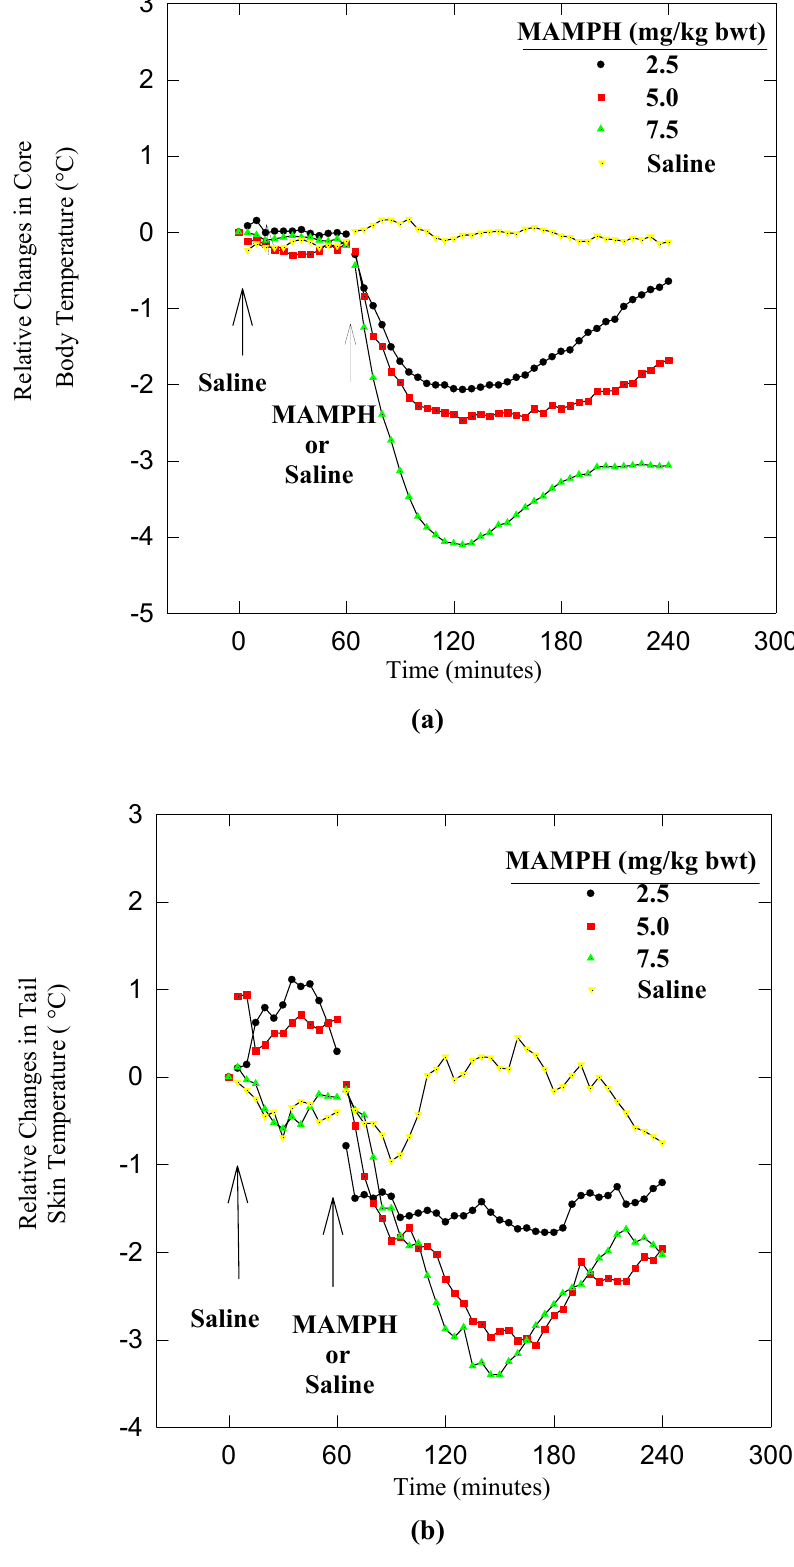
Figure 3. Effects of methamphetamine on a) core body and b) tail skin temperature at 7±